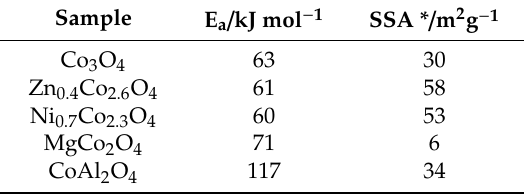
Table 1. Activation energies for N 2 O decomposition for selected bulk-doped Co 3 O 4.